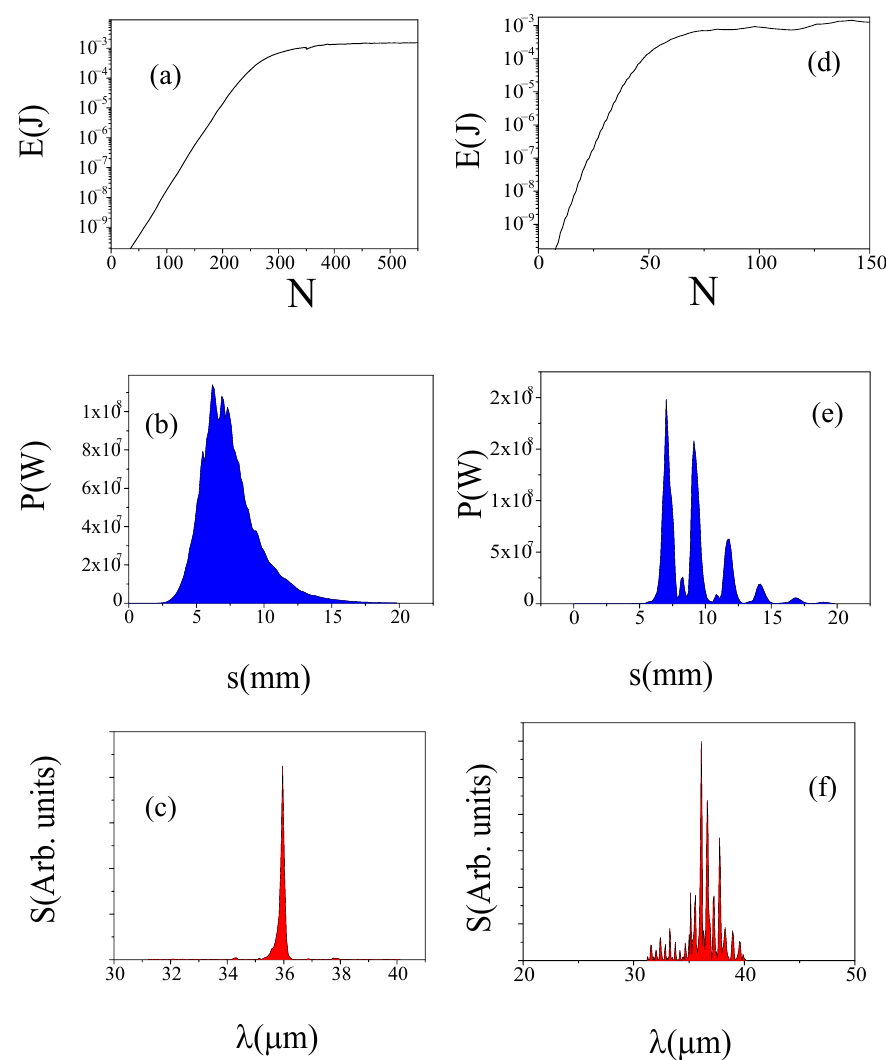
Figure 5. Radiation at λ = 35 µ m from an electron beam of 40 MeV with an undulator of period λ w = 4.5 cm. Left column: undulator length L w = 2 m. Right column: undulator length L w = 3 m. ( a , d ) Energy growth (J) as a function of the number N of shots; ( b , e ) power profile (W) vs. s (mm). ( c , f ) Spectral profile in arbitrary units vs. λ ( µ